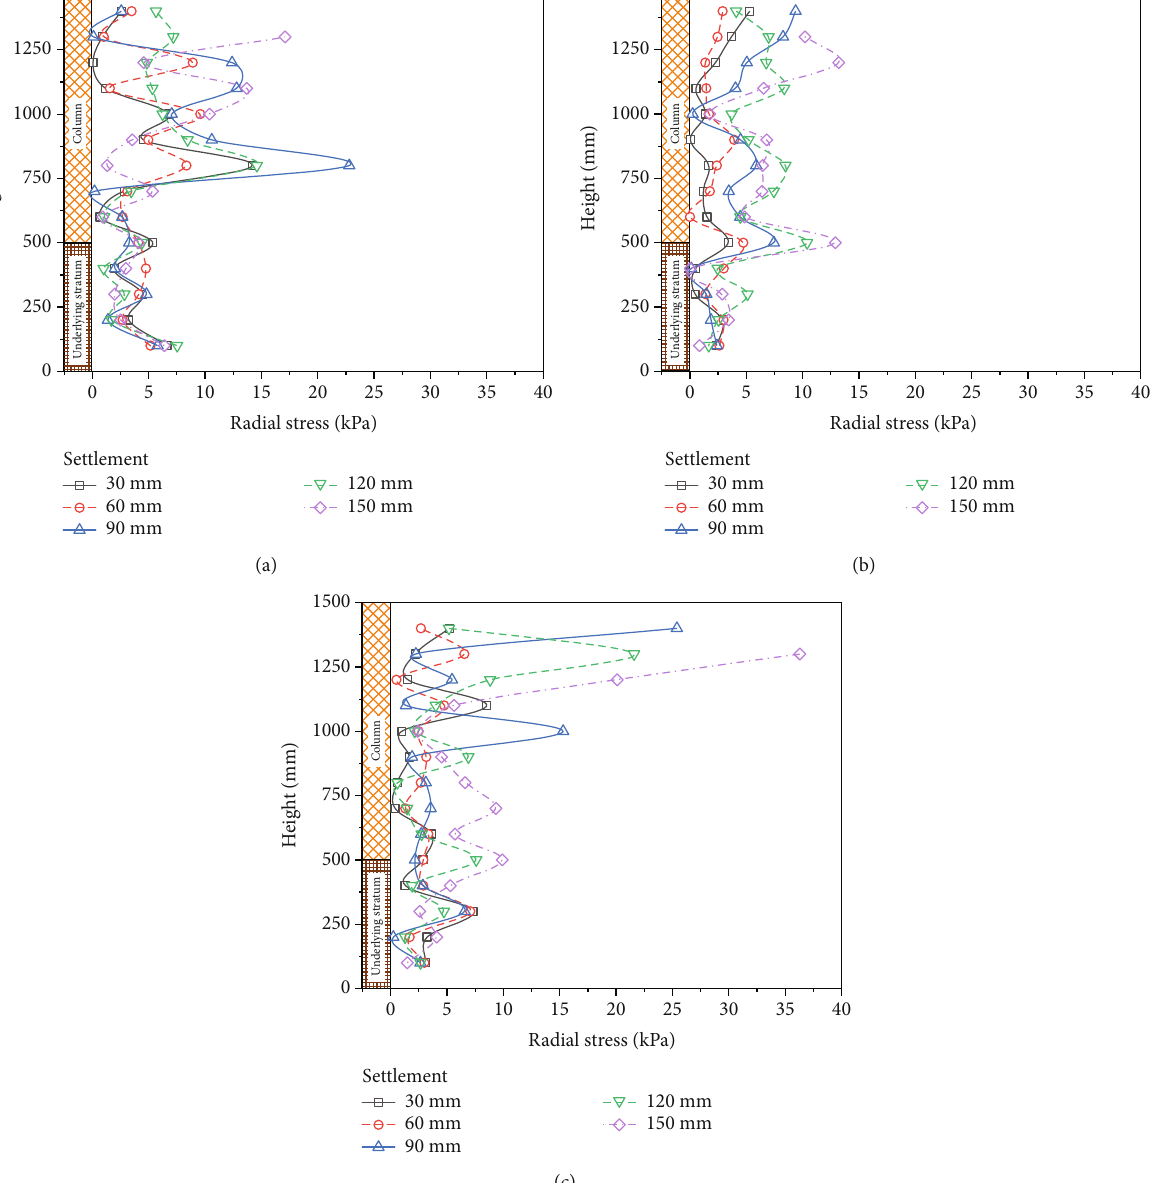
Figure 10: Radial stresses of the soft soil: (a) 180mm, (b) 280 mm, and (c) 350 mm away from the center of the